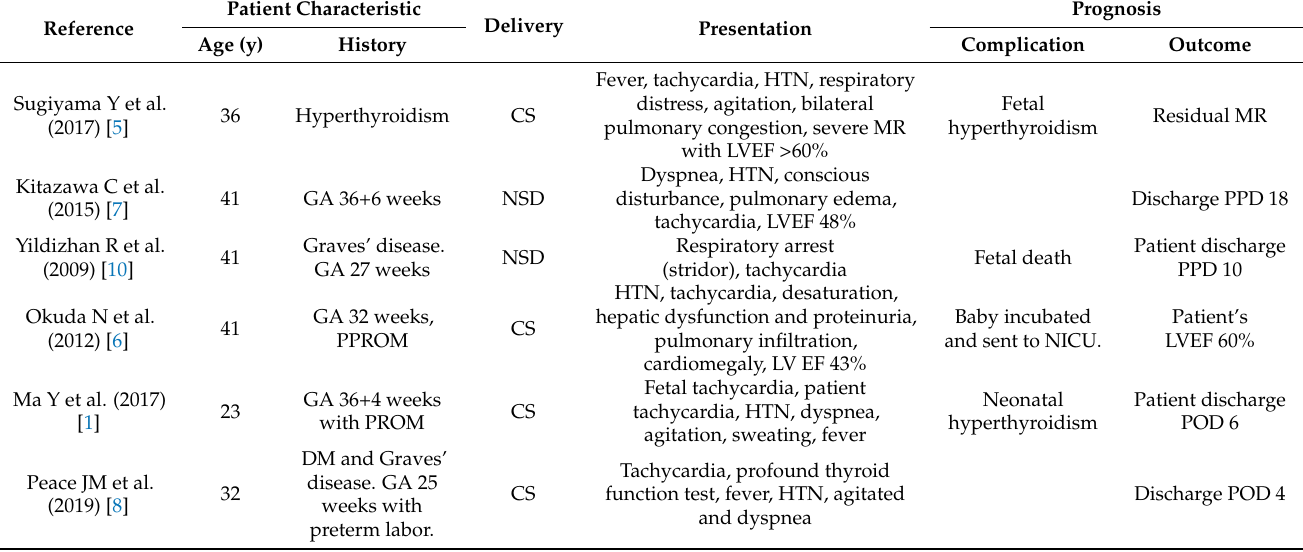
Table 3. Cases of peripartum thyroid storm in previous case reports. The patient characteristics, delivery, clinical presentations, and prognosis are